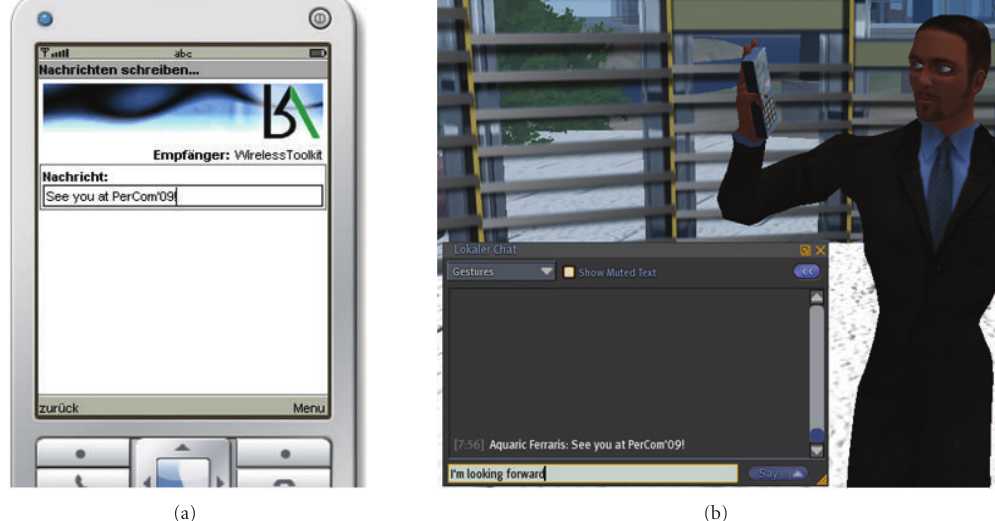
Figure 5: The cross-platform message exchange bridges between a mobile phone (Bluetooth) and the Second Life chat functions (Ethernet and Web Services). Students make use of their personal phone or corresponding virtual